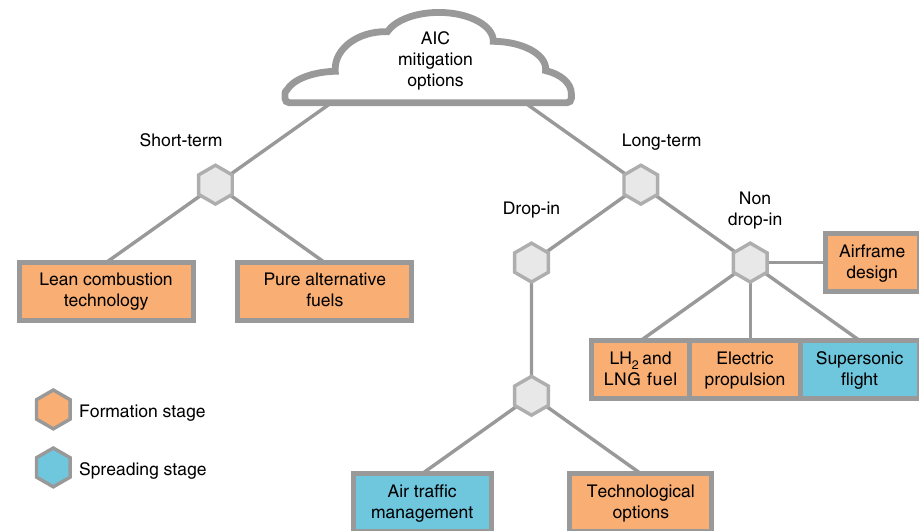
Fig. 8 Options to mitigate the climate effect of aircraft-induced clouds. Options are categorised into short-term and long-term solutions. Long-term options are further distinguished as drop-in (easily replaceable) and non-drop-in approaches. Mitigation options may also be categorised according to their in fl uence in the two stages of AIC evolution. Most options, including technological options addressing alterations of aircraft engine architecture and airframe/engine integration, affect the formation stage (red) by reducing or modifying particle emissions or affecting nucleation and sublimation of contrail ice crystals in aircraft exhaust plumes and wakes. Only two options affect the spreading stage (blue), requiring sound predictive capability of